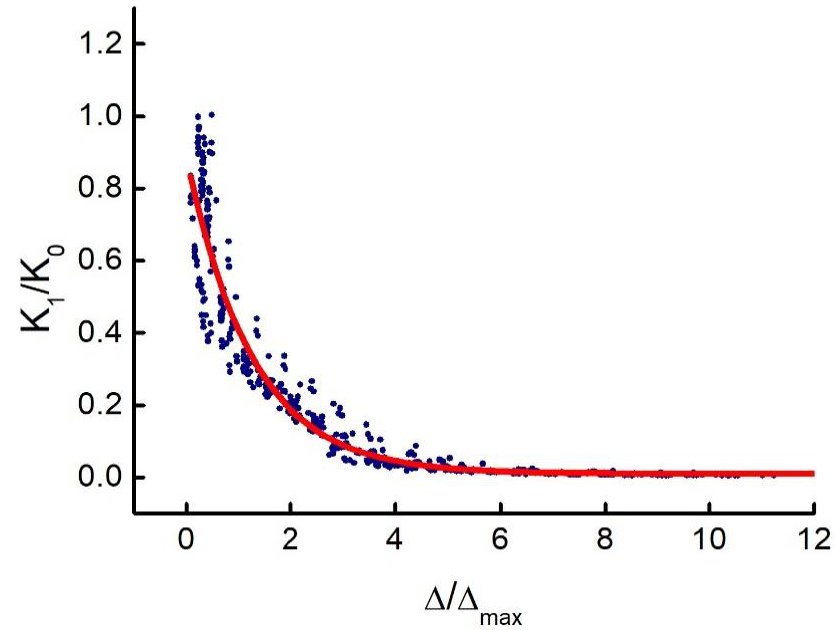
Figure 10. Stiffness degradation curve.